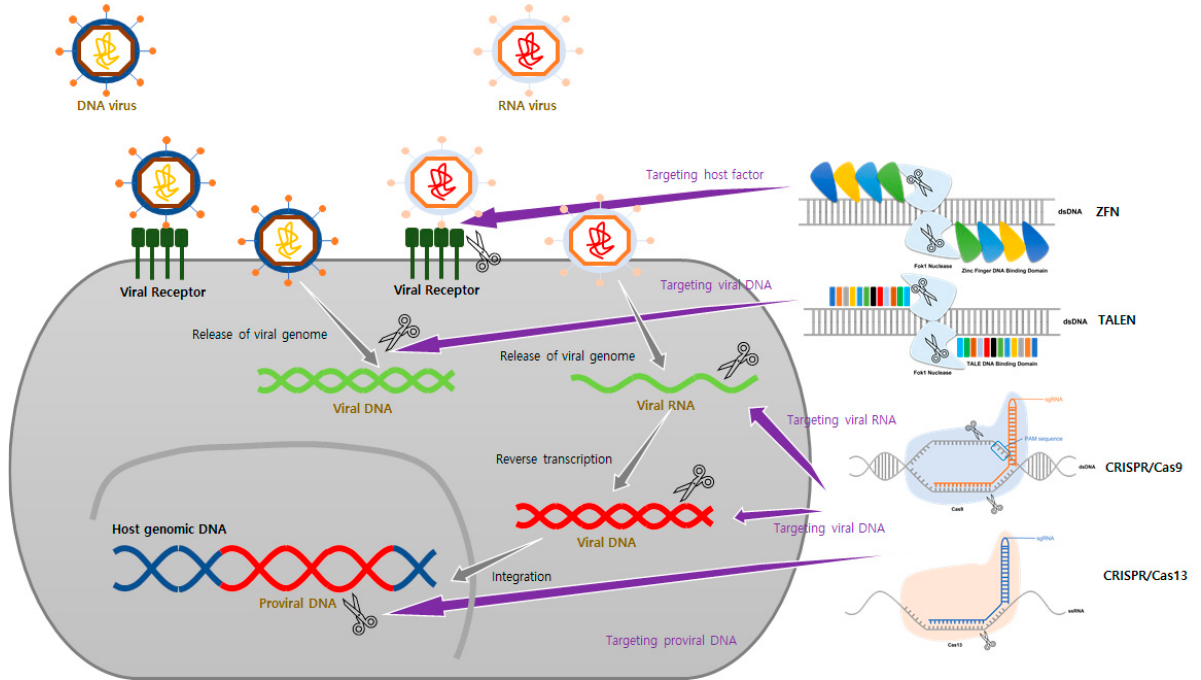
Figure 2. Schematic of genome editing tools used to develop antiviral therapeutic agents. According to each stage of the virus life cycle, targets of genome editing tools can vary. (1) It suppresses the life cycle of a virus by targeting host factors that interact at various stages, such as entry and replication of the virus. (2) Virus replication can be inhibited by directly targeting the genome of a virus that has DNA or RNA as its genome. (3) It is also possible to develop therapeutic agents by targeting the provirus, the genome of a virus that has been integrated into the host Table 2. Summary data of antiviral genome editing technologies against virus types classified based on the Baltimore classification and used in this review.